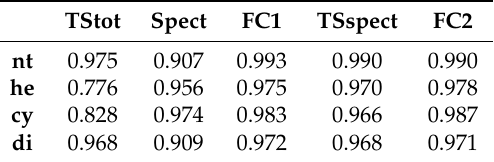
Table A4. Best ANNs’ F 1 score for wideband excitation (150kHz to 20kHz); grouped by shapes. Compare also Figure 8b.